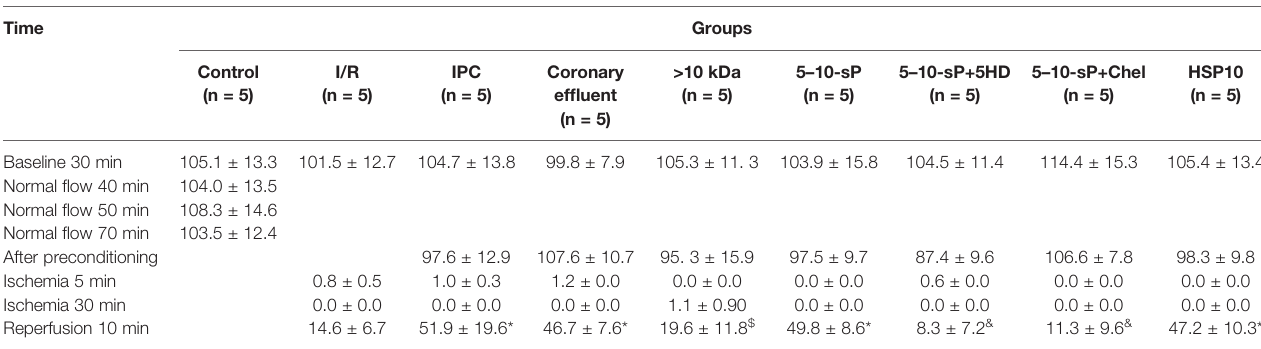
TABLE 1 | Left ventricular developed pressure of isolated perfused rat